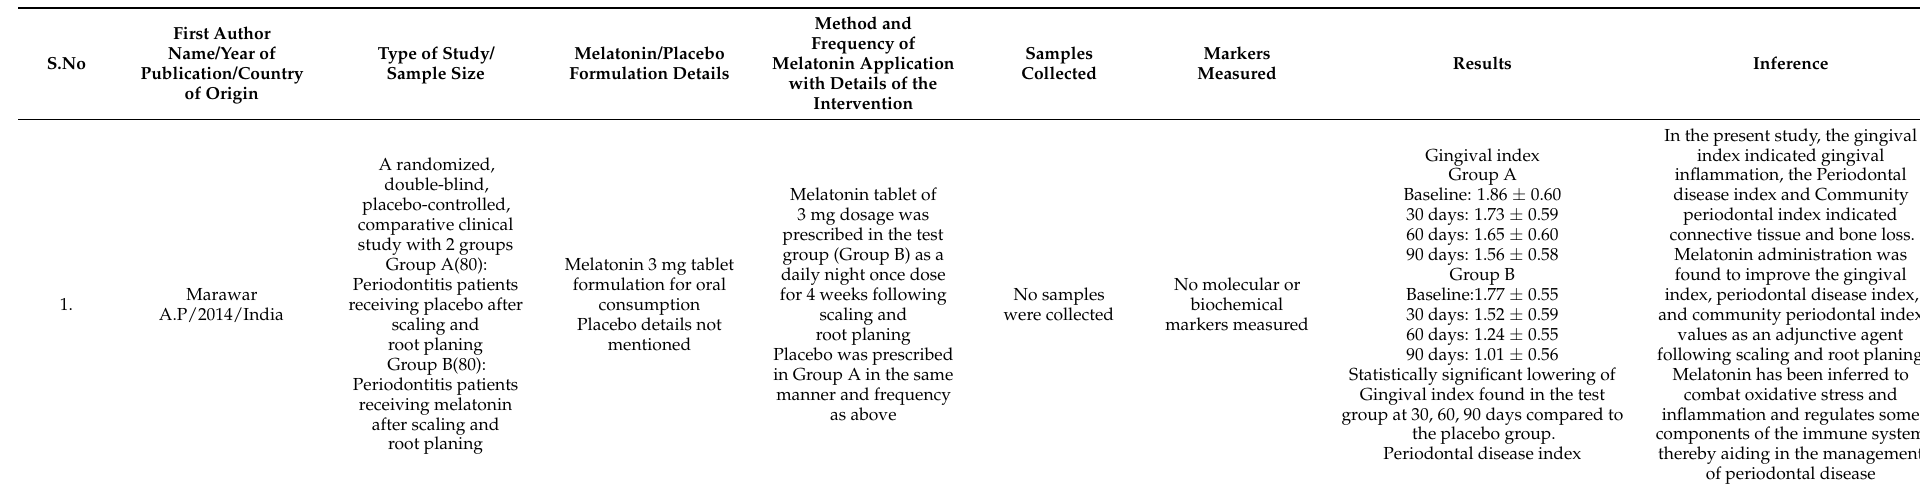
Table 3. Detailed data extracted from the included studies using systemic melatonin